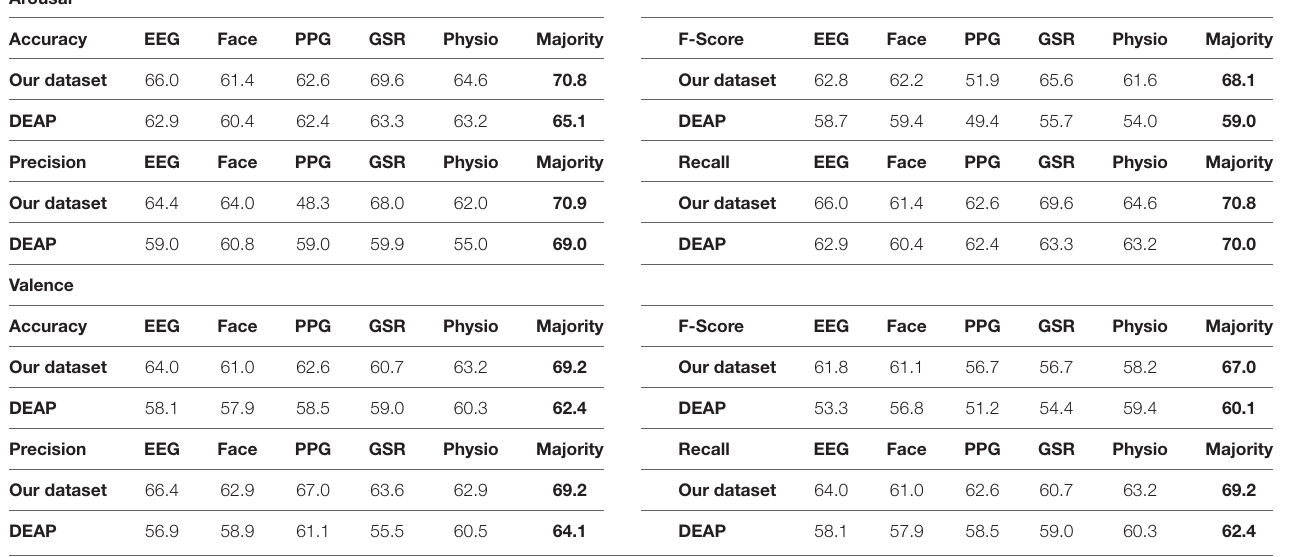
TABLE 7 | Accuracy, F-score, precision, and recall for arousal and valence. Arousal Accuracy Our dataset